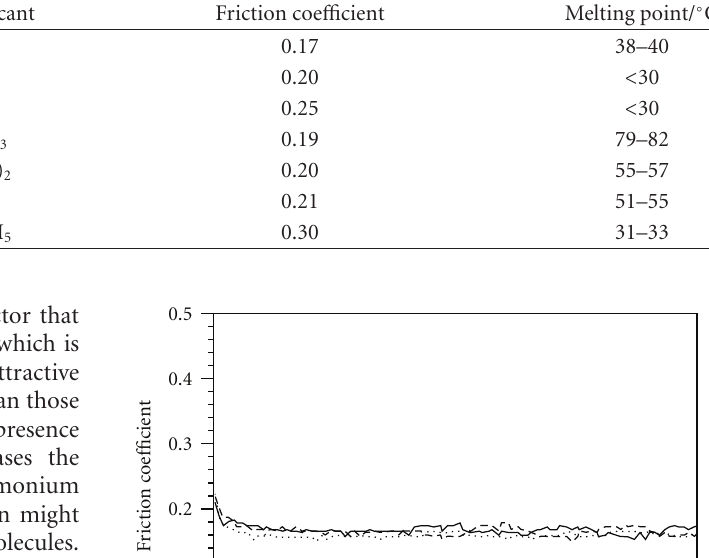
Table 4: Fiction coe ffi cients and melting points of the lubricants with the molecular structure of the amine having 18 carbon chains. Lubricant number